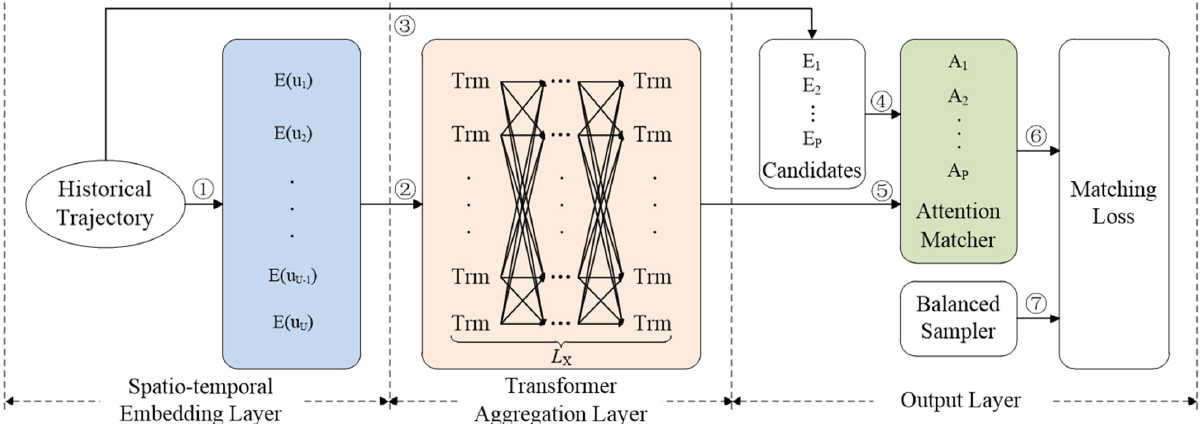
Figure 2. The framework of the proposed STTF-Recommender. Spatio-Temporal embedding layer is used to encode user, location, and time from the historical trajectory into latent representations ① . Transformer aggregation layer is exploited to gather the locations of visits ② and update the hidden representation of each visit by stacking the Transformer layers so that our model can better mine the spatio-temporal relationship between non-adjacent locations and non-contiguous visits in the user trajectory sequence. Output layer is further divided into two modules: attention matcher and balance sampler, where attention matcher calculates the probability of each candidate location becoming the next visit location according to candidate location ③ , ④ and hidden representation of each visit ⑤ . The balance sampler then calculates the cross-entropy loss using one positive sample and multiple negative samples ⑥ , ⑦ .